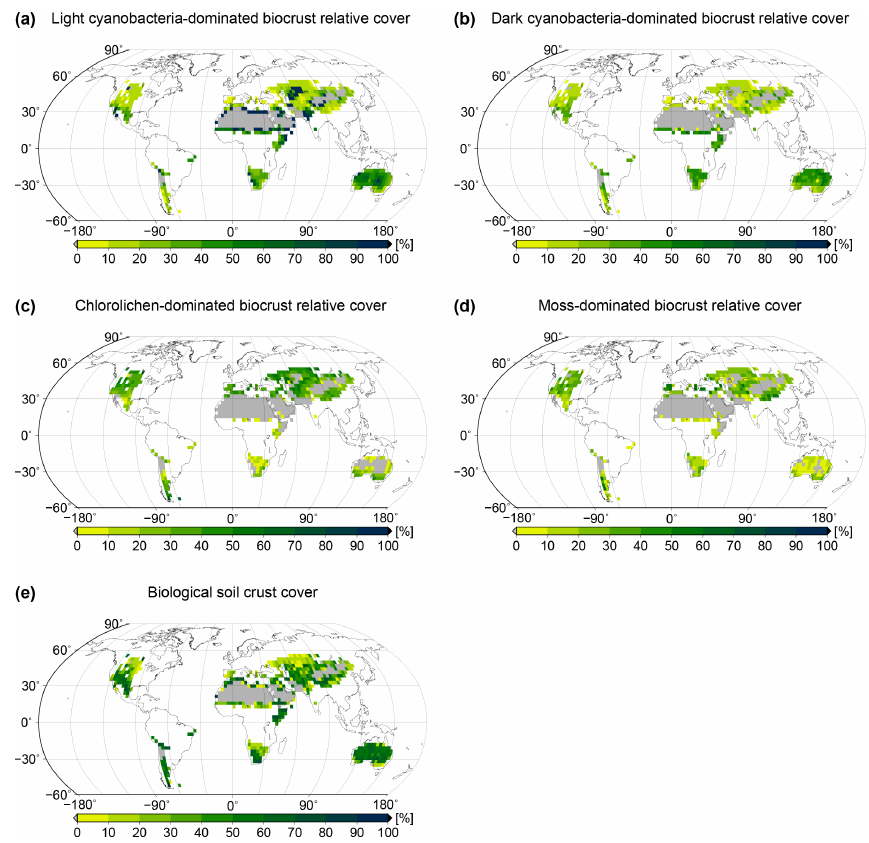
Figure 4. Global patterns of biological soil crust cover simulated by the LiBry model. Relative cover of (a) light cyanobacteria-dominated, (b) dark cyanobacteria-dominated, (c) chlorolichen-dominated, and (d) moss-dominated biocrusts is shown, and also (e) total biocrust surface cover. White areas at the land surface denote regions which are excluded since they do not belong to the biomes desert, steppe, savanna, and mediterranean woodlands, or they exhibit more than 700mm of annual rainfall. Grey areas denote regions where no simulated strategies are able to survive, although they match the above criteria for biocrust